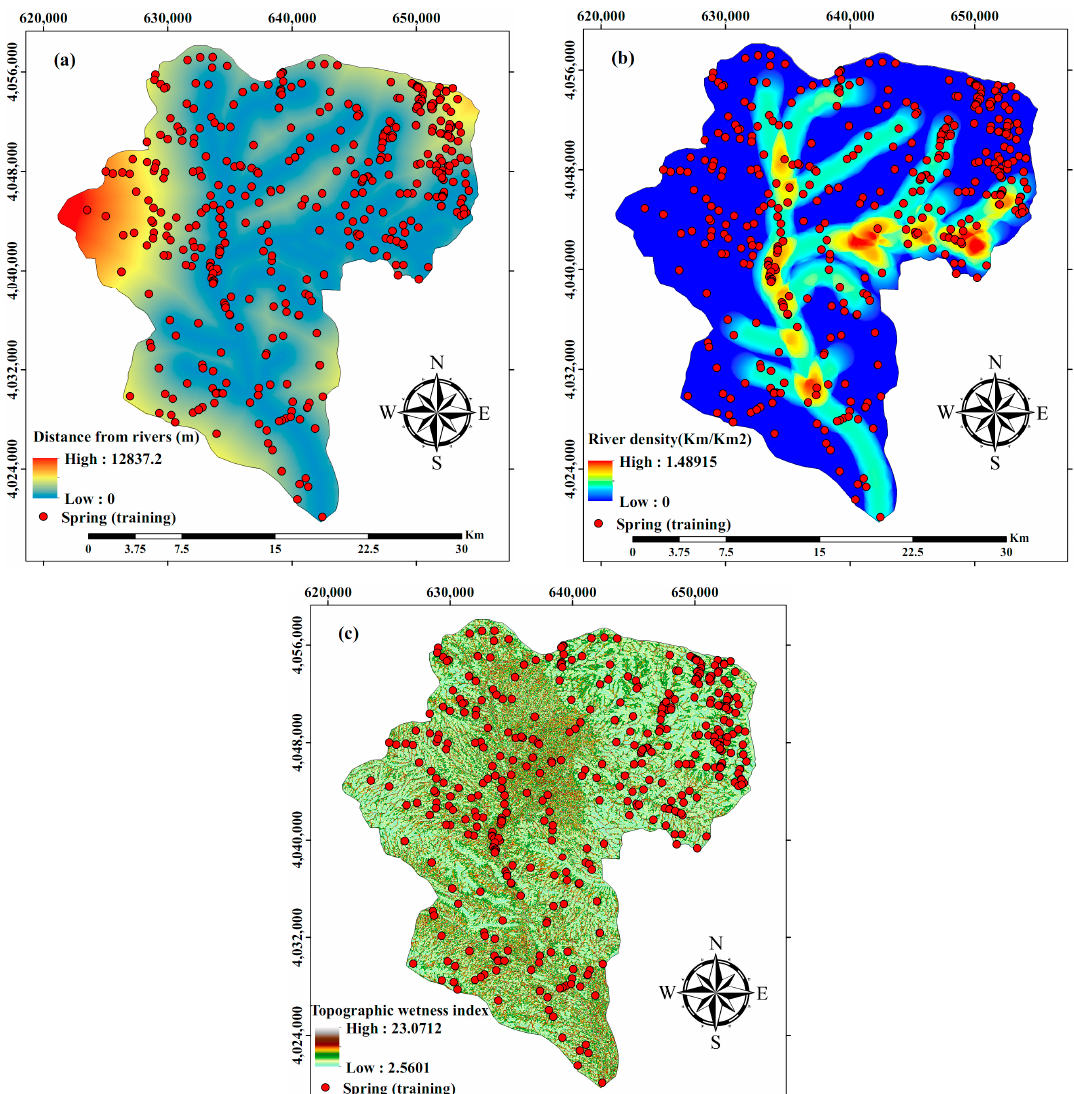
Figure 4. Hydrological driving factors of the Hesare-No Basin including ( a ) distance from rivers, ( b ) river density, and ( c ) topographic wetness index.